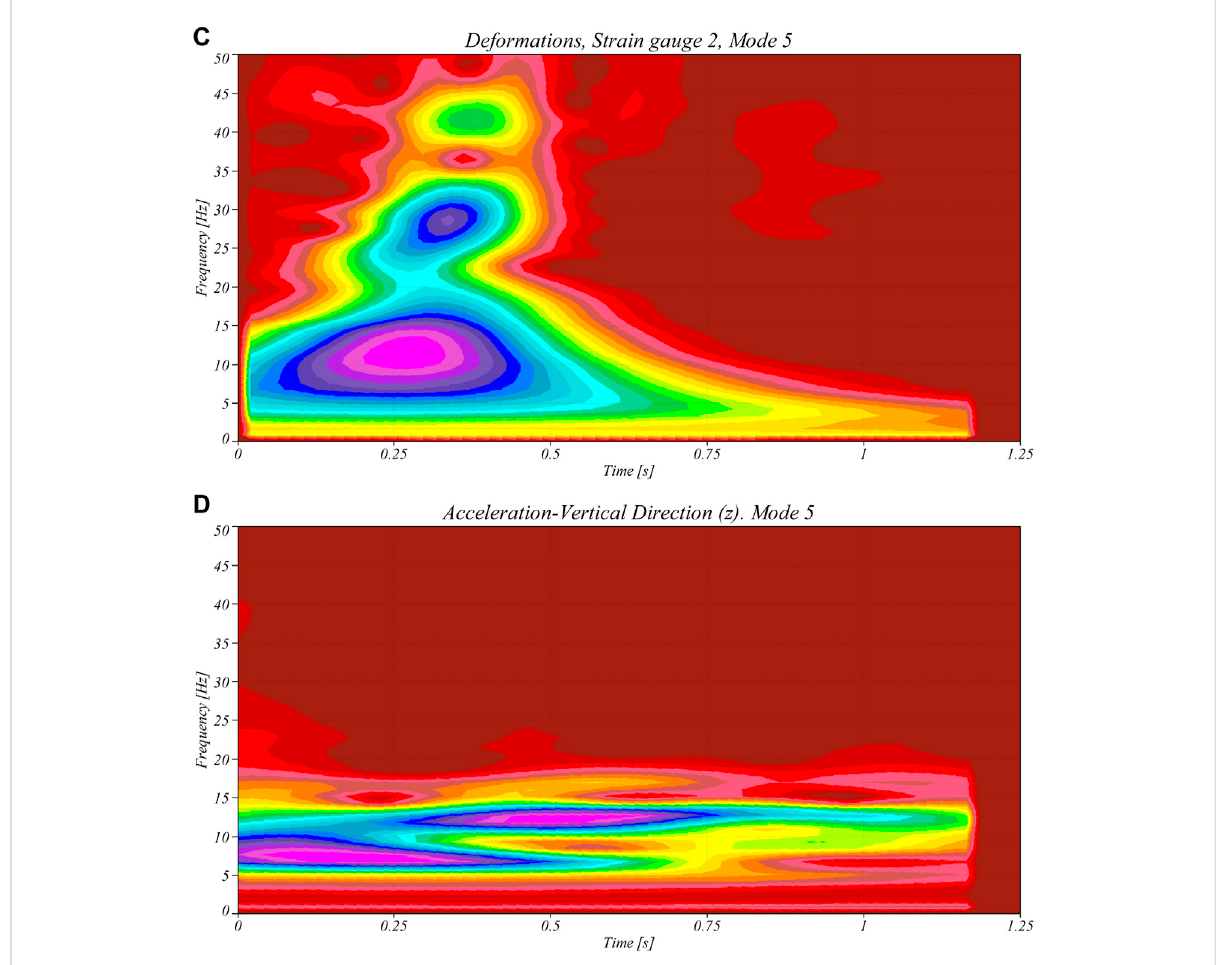
FIGURE 4 Spectrogram Comparison. (A) Deformations in strain gauge 2, non-periodic modes. (B) Acceleration in the vertical direction, non-periodic modes. (C) Deformations in strain gauge 2, mode 5. (D) Accelerations in the vertical direction, mode